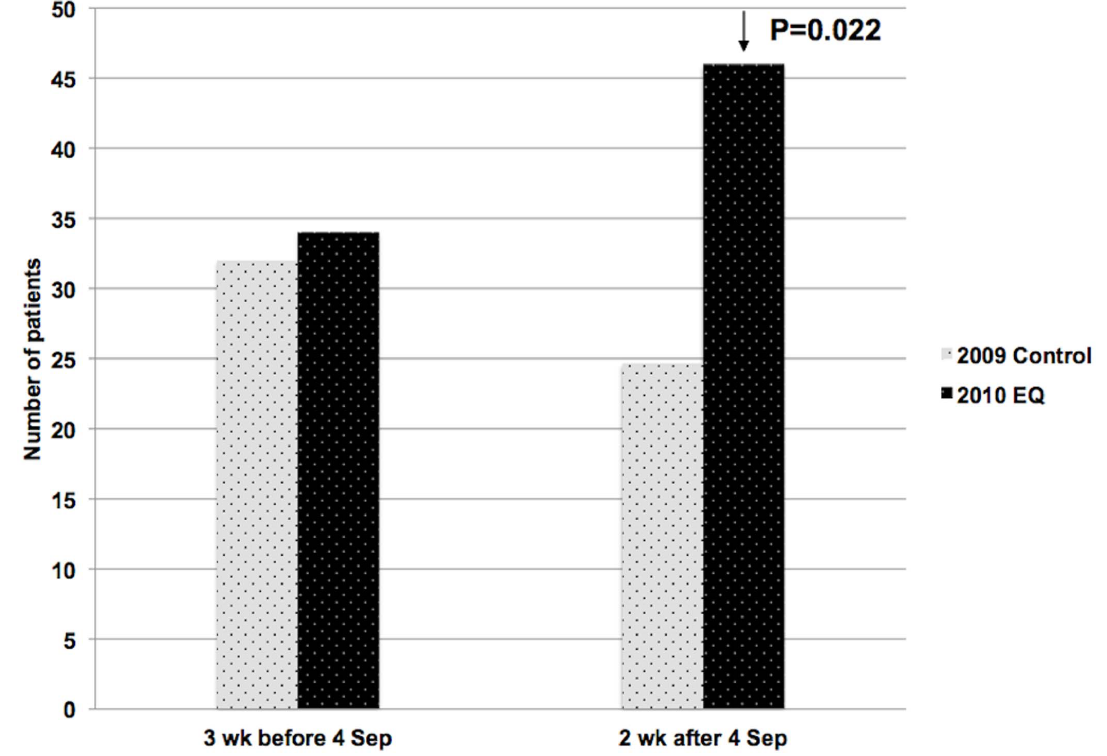
Figure 3. Mean NCCP admissions 3 weeks before and 2 weeks after the September 2010 earthquake.